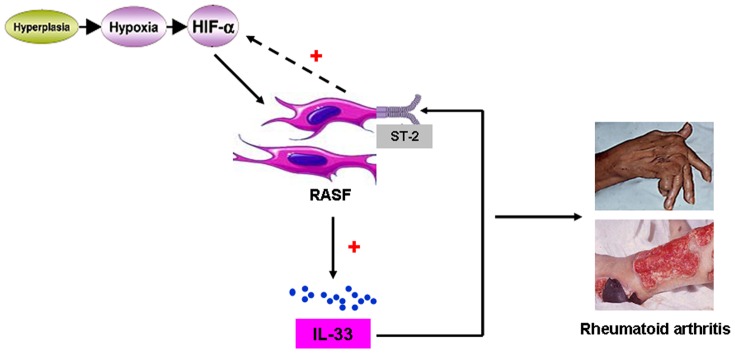
HIF-1α/IL-33 self-amplification circuit exacerbates the inflammation in RA.Rheumatoid arthritis synovial fibroblast (RASF) hyperplasia leads to tissue hypoxia, which induces upregulated expression of HIF-1α. This upregulated HIF-1α expression provokes IL-33 production by RASF, one of the main sources of IL-33. IL-33 in turn enhances HIF-1α expression in RASF, thus forming a self-amplification circuit that would perpetuate the inflammatory process in RA.